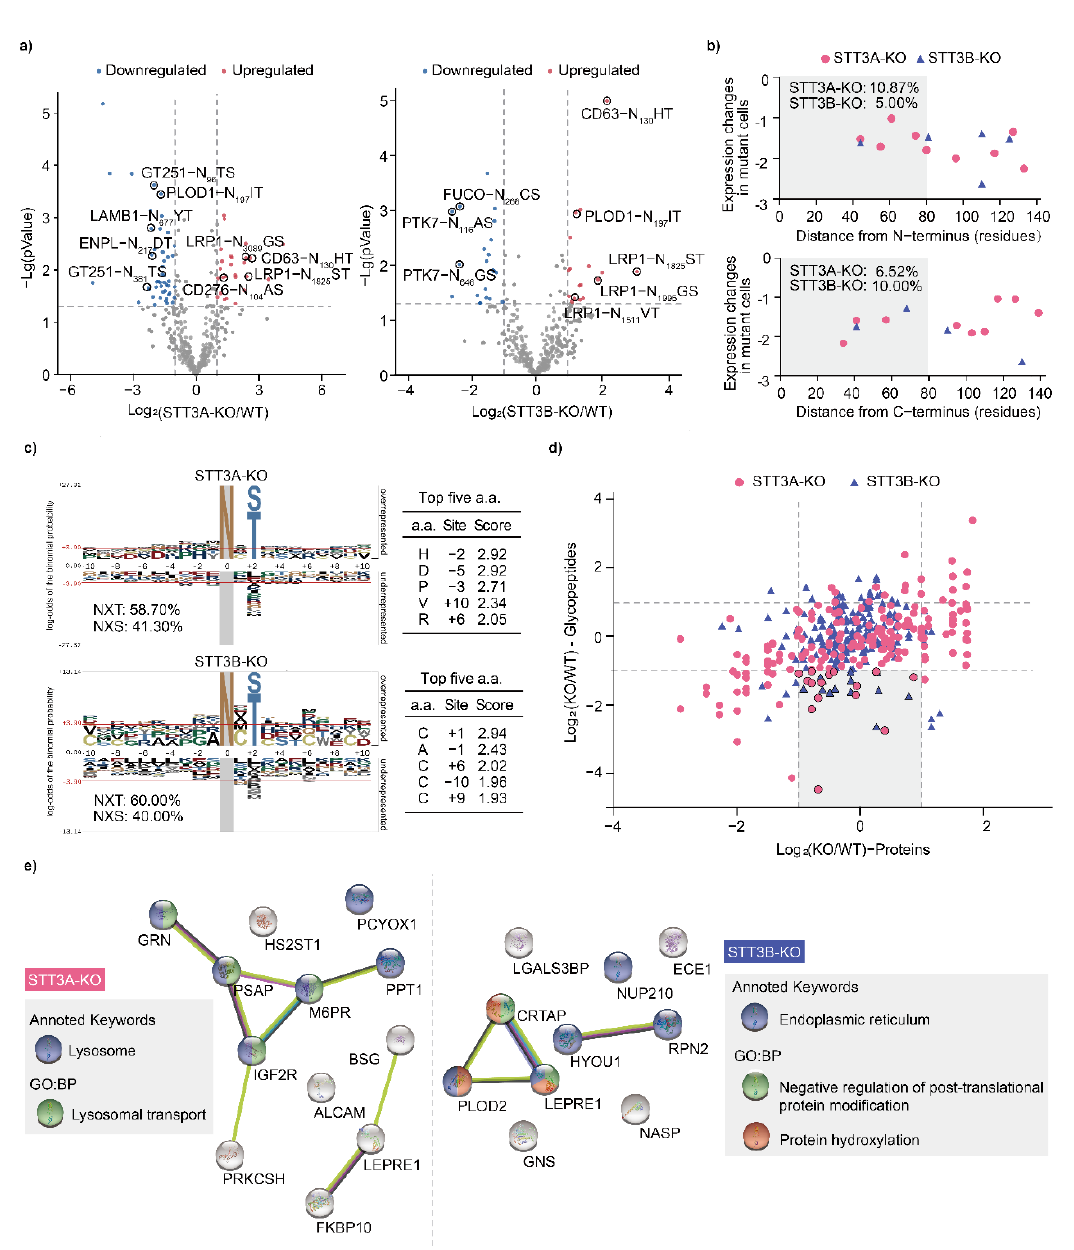
Figure 3. Differential expression of glycopeptides and N-glycosylation preference between WT and KO HEK293 cells. ( a ) Volcano plot of glycopeptides expression. The dashed line represents a two-fold change ( X -axis) and p -Value < 0.05 ( Y -axis) in KO cells compared to WT cells. ( b ) Scatter diagram of N-glycosites. The distance of the N-glycosites from the N-terminus (upper) or C-terminus (bottom) of the proteins is shown. The Y -axis values represent changes in glycopeptide abundance (log 2 ) between KO cells and WT cells. The percentages of affected N-glycosylation sites within 80 amino acids from the N-terminus or C-terminus are listed. ( c ) Frequencies of ten amino acids before and after the N-glycosite in glycopeptides. The top five amino acids around N-glycosylation sites with high probability in STT3A-KO and STT3B-KO cells are listed. ( d ) Scatter diagram of N-glycosites and correlated proteins expression in KO cells compared with WT cells. ( e ) Protein–protein interaction (PPI) and annotation of glycoproteins with decrease N-linked glycosylation in STT3A-KO (left) and STT3B-KO (right)